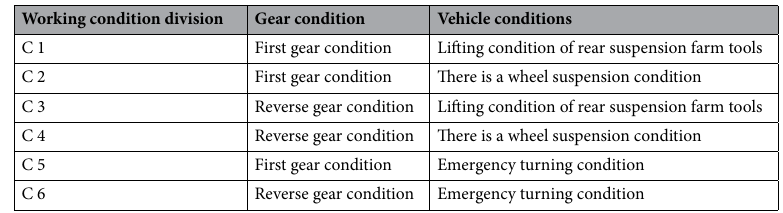
Table 3. Simulation conditions.